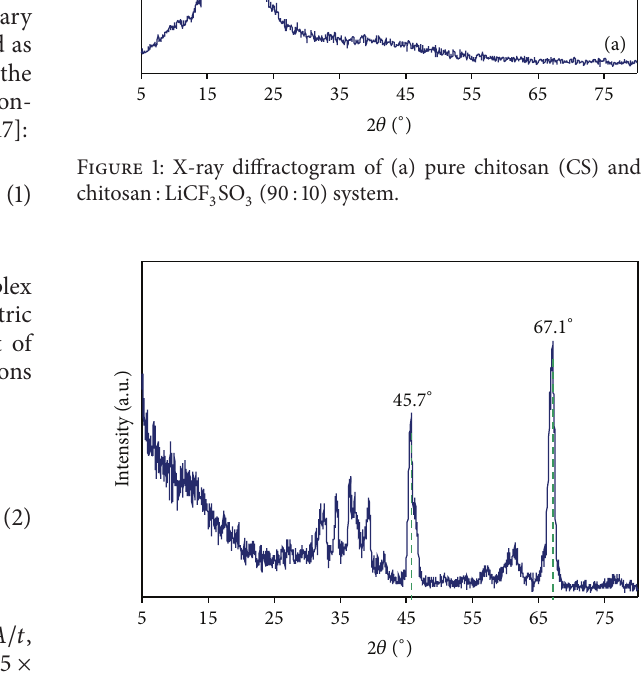
Figure 2: XRD patterns of pure Al 2 O 3 nanoparticles.